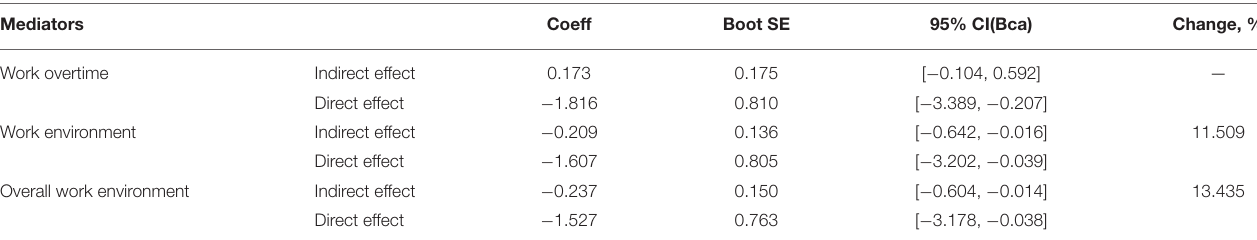
TABLE 5 | The impact of work environment on the psychological well-being of manufacturing workers: a test of mediating effects based on the Bootstrap method.